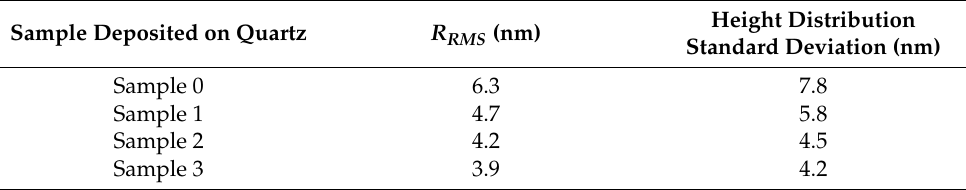
Table 3. Height Distribution Standard Deviation resulted from histograms of 2D AFM images and R RMS of Cu 2 O thin films [42].